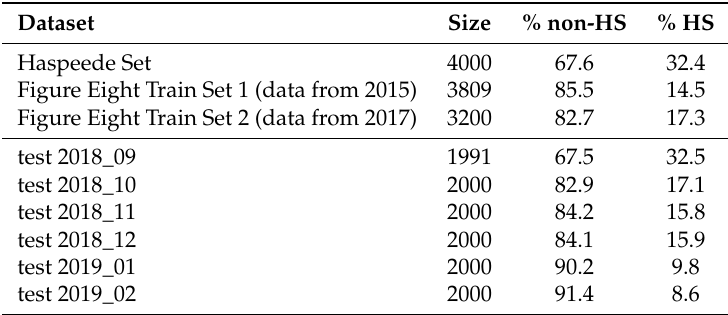
Table 2. Dataset size and class